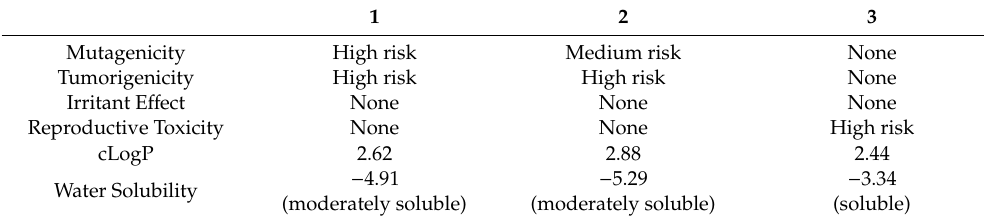
Table 3. Predicted toxicity parameters of compounds 1 – 3 .